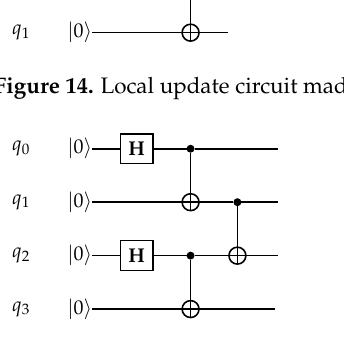
Figure 15. Local update circuit made of four